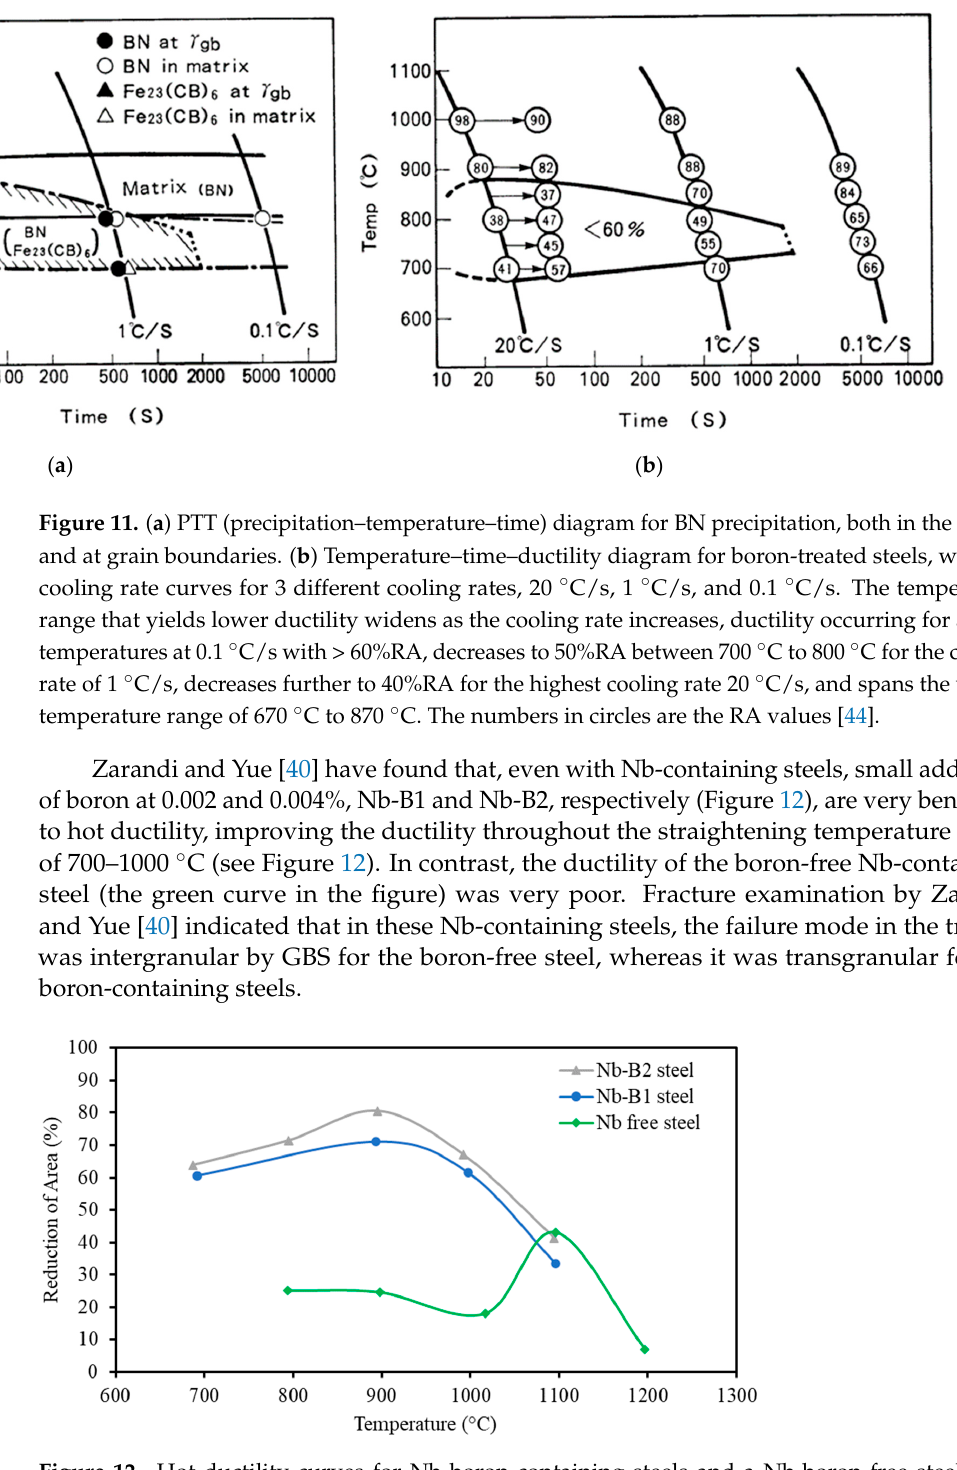
Figure 12. Hot ductility curves for Nb boron-containing steels and a Nb-boron-free steel. The Nb-boron-containing steels had the base composition of 0.015% C, 1.65% Mn, 0.05% Nb, 0.02% Ti, 0.005% N, and 0.008% S, and the B additions were 0.002% for B1 and 0.004% for B2. The boron-free, Nb-containing steel had a somewhat different composition, with 0.05% C and 0.009%N. A thermal schedule was used, which included undercooling [40].